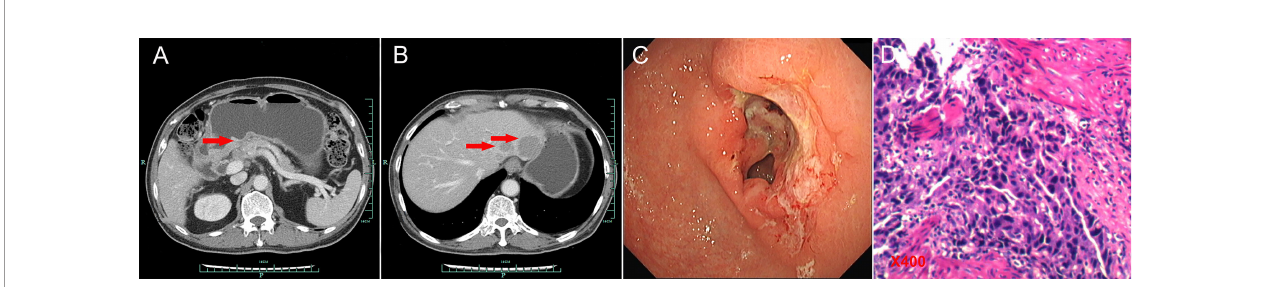
FIGURE 1 | Abdominal CT scans and gastroscopy fi ndings at baseline. (A) Abdominal CT scans suggested thickened gastric wall in the antrum (red arrow for tumor). (B) Abdominal CT scans showed liver metastasis (red arrows for tumors). (C) Gastroscopy examinations revealed gastric ulcer. (D) Histological fi nding with hematoxylin and eosin – stained biopsy specimen from gastroscopy